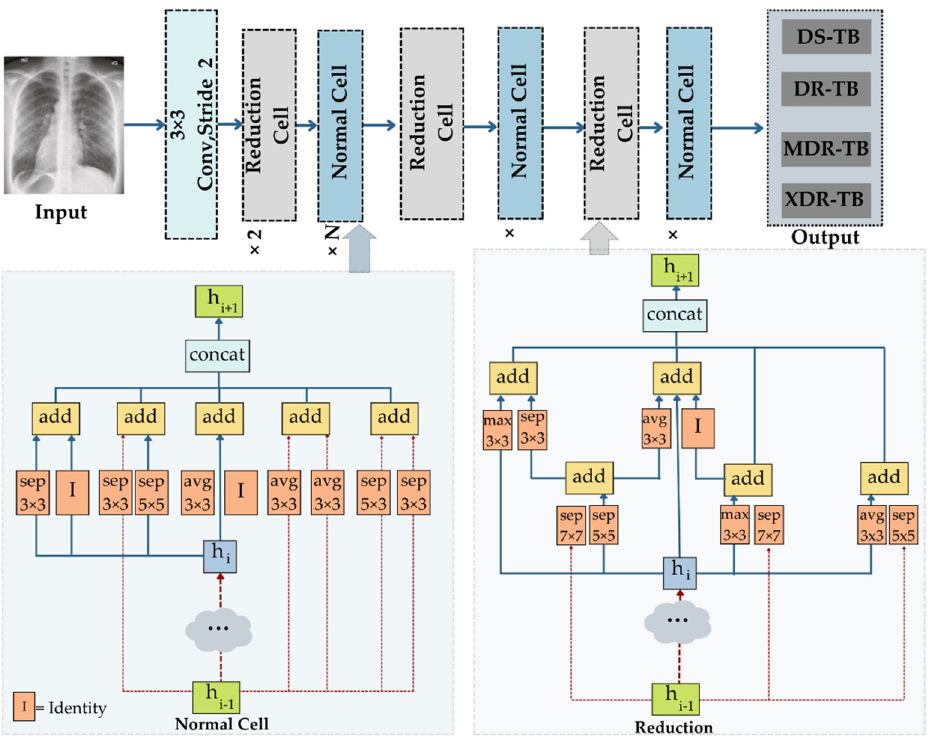
Figure 9. The NASNetMobile architecture. All the architectures that are previously explained will be used in both heterogeneous and homogeneous manners in the ensemble deep learning, as shown in Figure 10.